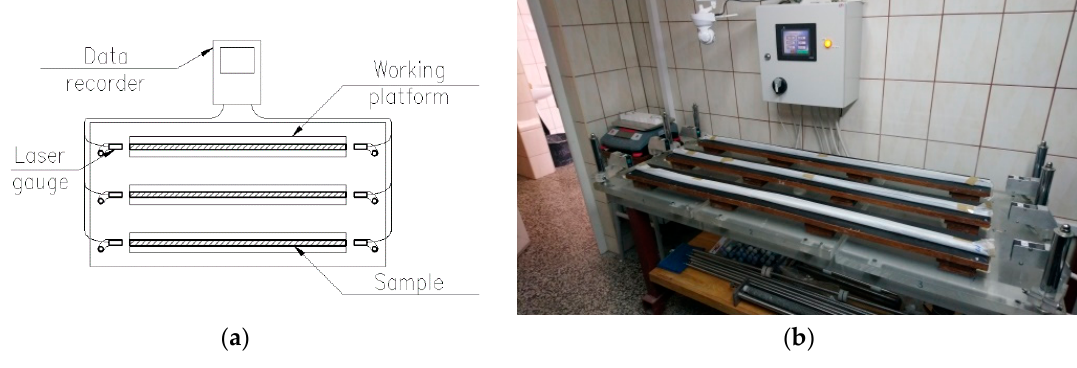
Figure 3. The testing site: ( a ) diagram; ( b ) actual site.